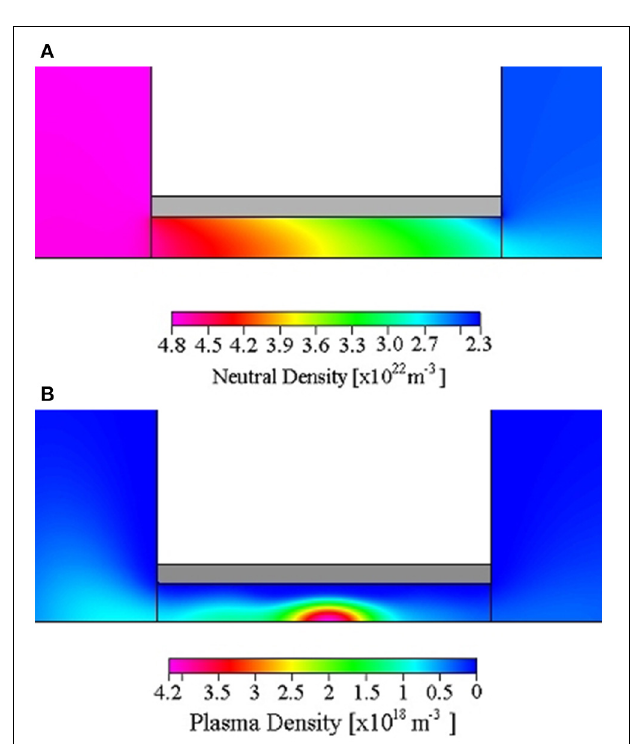
FIGURE 4 | Two dimensional, time averaged CFD simulation results for (A) neutral gas density and (B) plasma density within the discharge tube. The full 2D plot has been cropped to show only the region of interest (discharge tube) for ease of